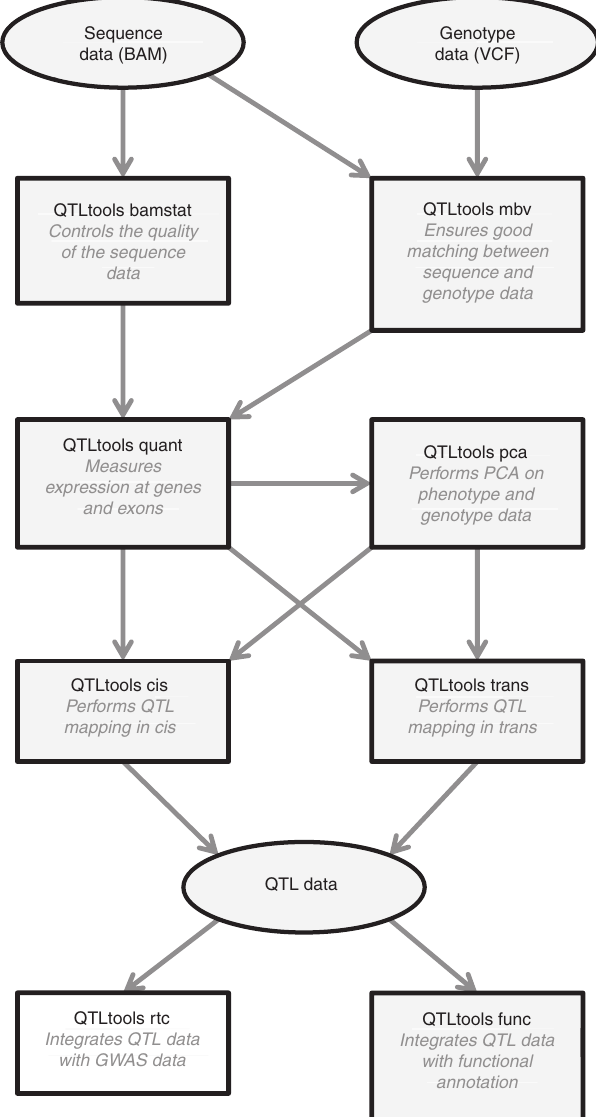
Figure 1 | Flow chart of the main QTLtools functionalities. This represents how the various functionalities of QTLtools can be combined to go from the raw sequence and genotype data to collections of molecular QTLs which can then be integrated with both GWAS data and functional annotations. Data is represented with ovals and tasks with boxes in which the name of the mode is shown in bold black with a short description of what it